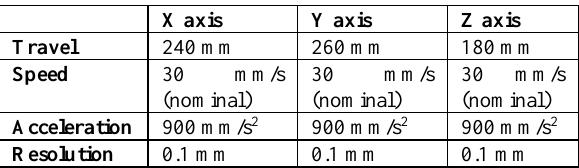
Table 1 . Main characteristics of the XYZ axes of the system.